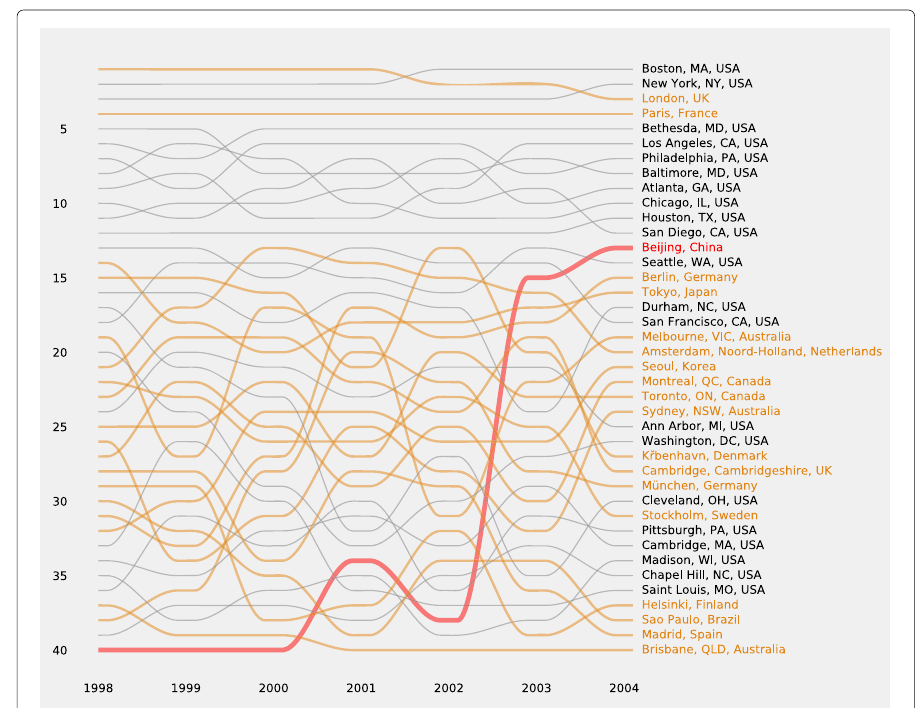
Fig. 2 PageRank ranking evolution from 1998 to 2004 for the top 40 cities as observed in the 2004 mobility